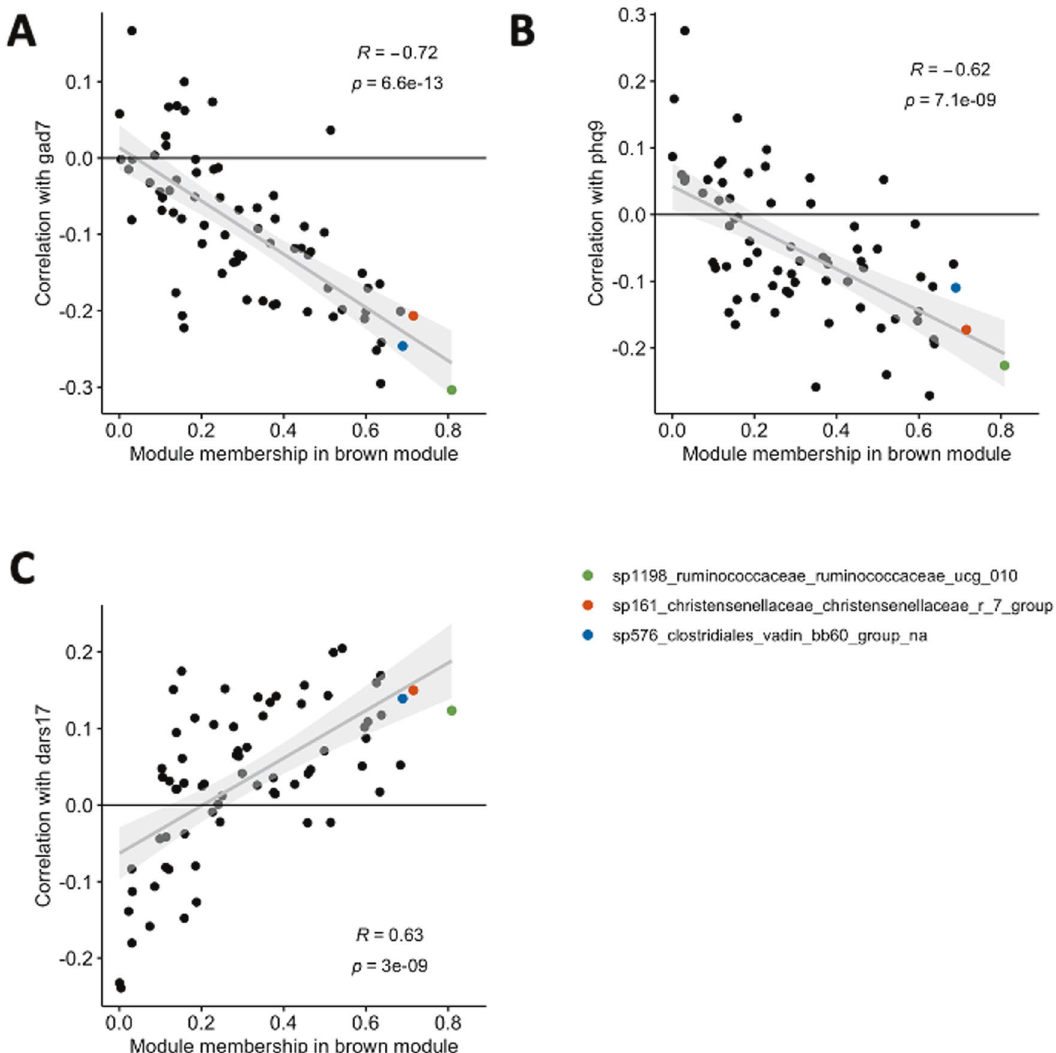
Fig. 4 Association between signed brown module taxa signi fi cance and brown module membership. Taxa signi fi cance is de fi ned here as the signed correlation between the taxa and clinical trait. Hub taxa for the brown module are highlighted as green, orange, or blue. A GAD7